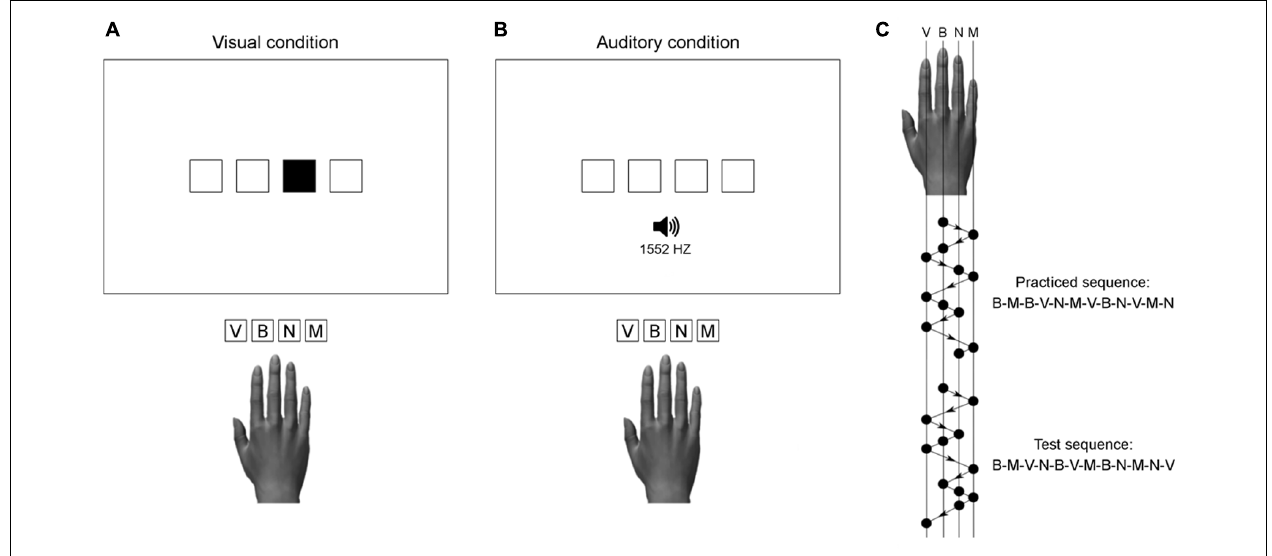
FIGURE 1 | Illustration of the stimulus-response mapping used in the visual (A) and auditory (B) practice condition. Auditory stimuli with frequencies of 300, 675, 1552, and 3565 Hz, were respectively assigned to the response keysV, B, N, and M.The practiced and test sequences (C) were matched for number of movements per digit and two-finger